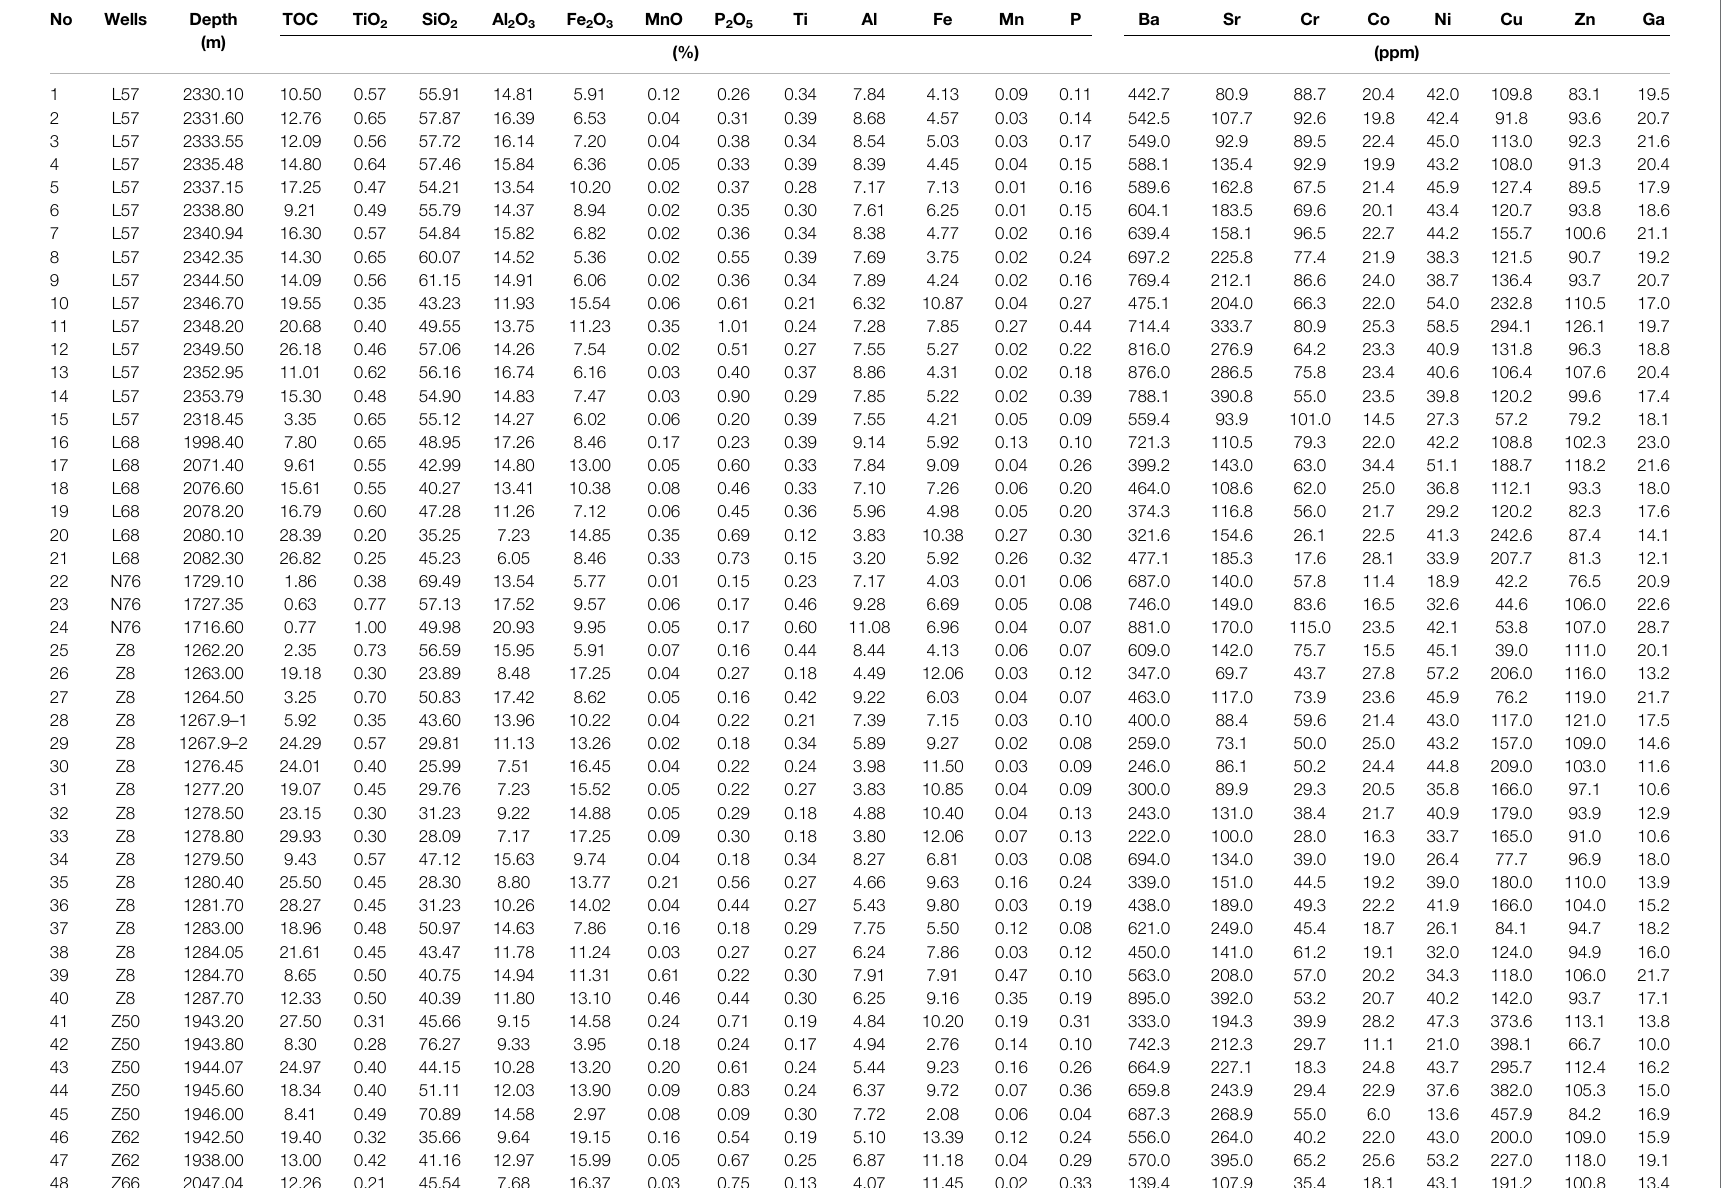
TABLE 1 | Selected major, trace elements data and geochemical indicators of the Chang 7 black shale in Ordos Basin. No Wells